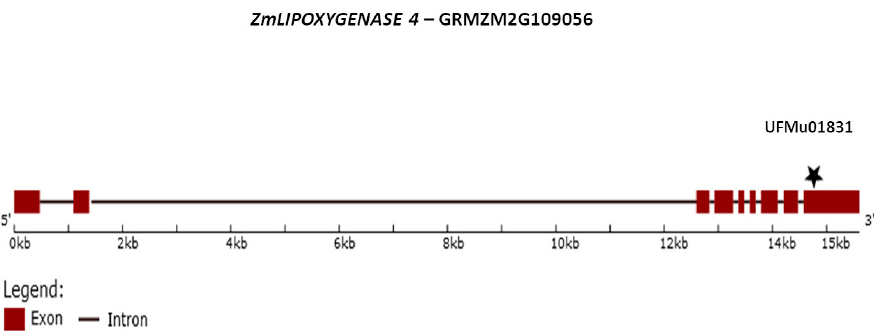
Figure 12. Mutator element insertion site for UFMu01831 in the ZmLIPOXYGENASE 4 gene model of inbred line W22.